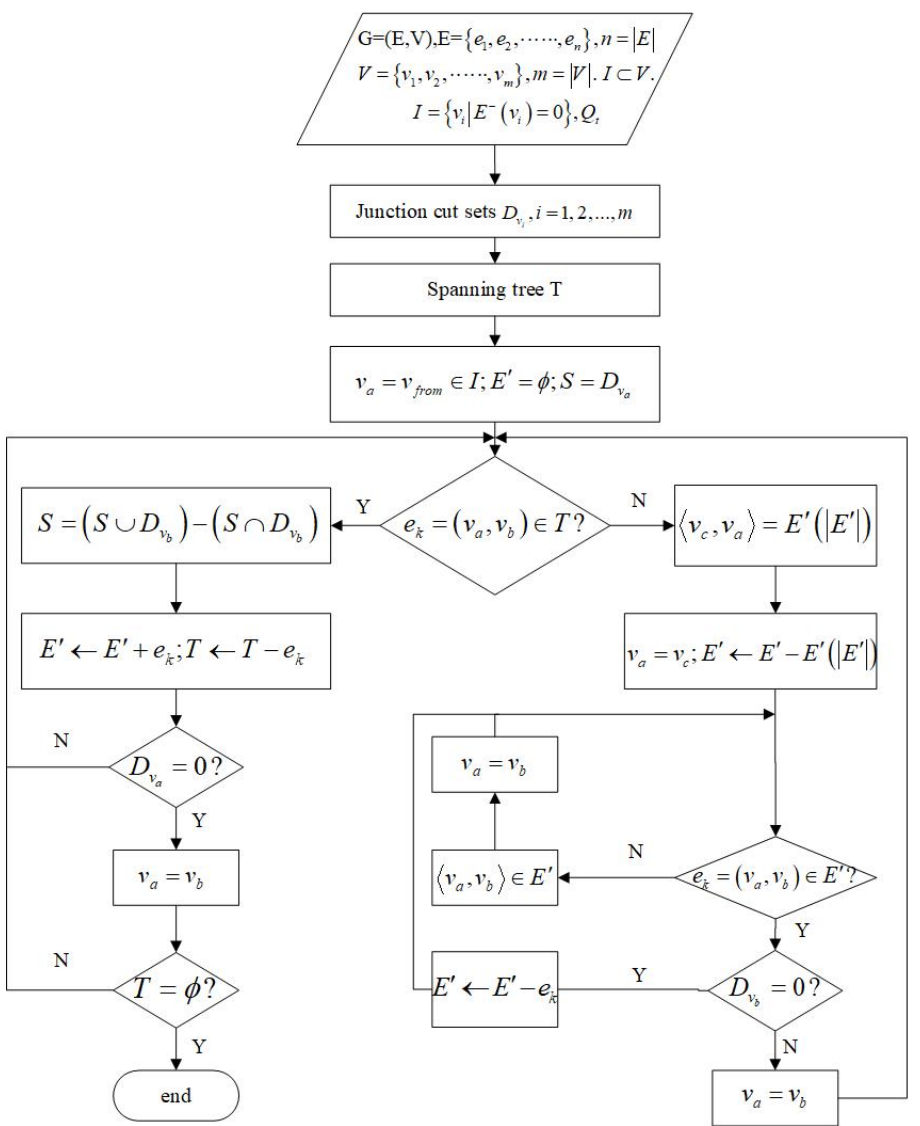
Figure 6. Flow diagram for the independent cut set.